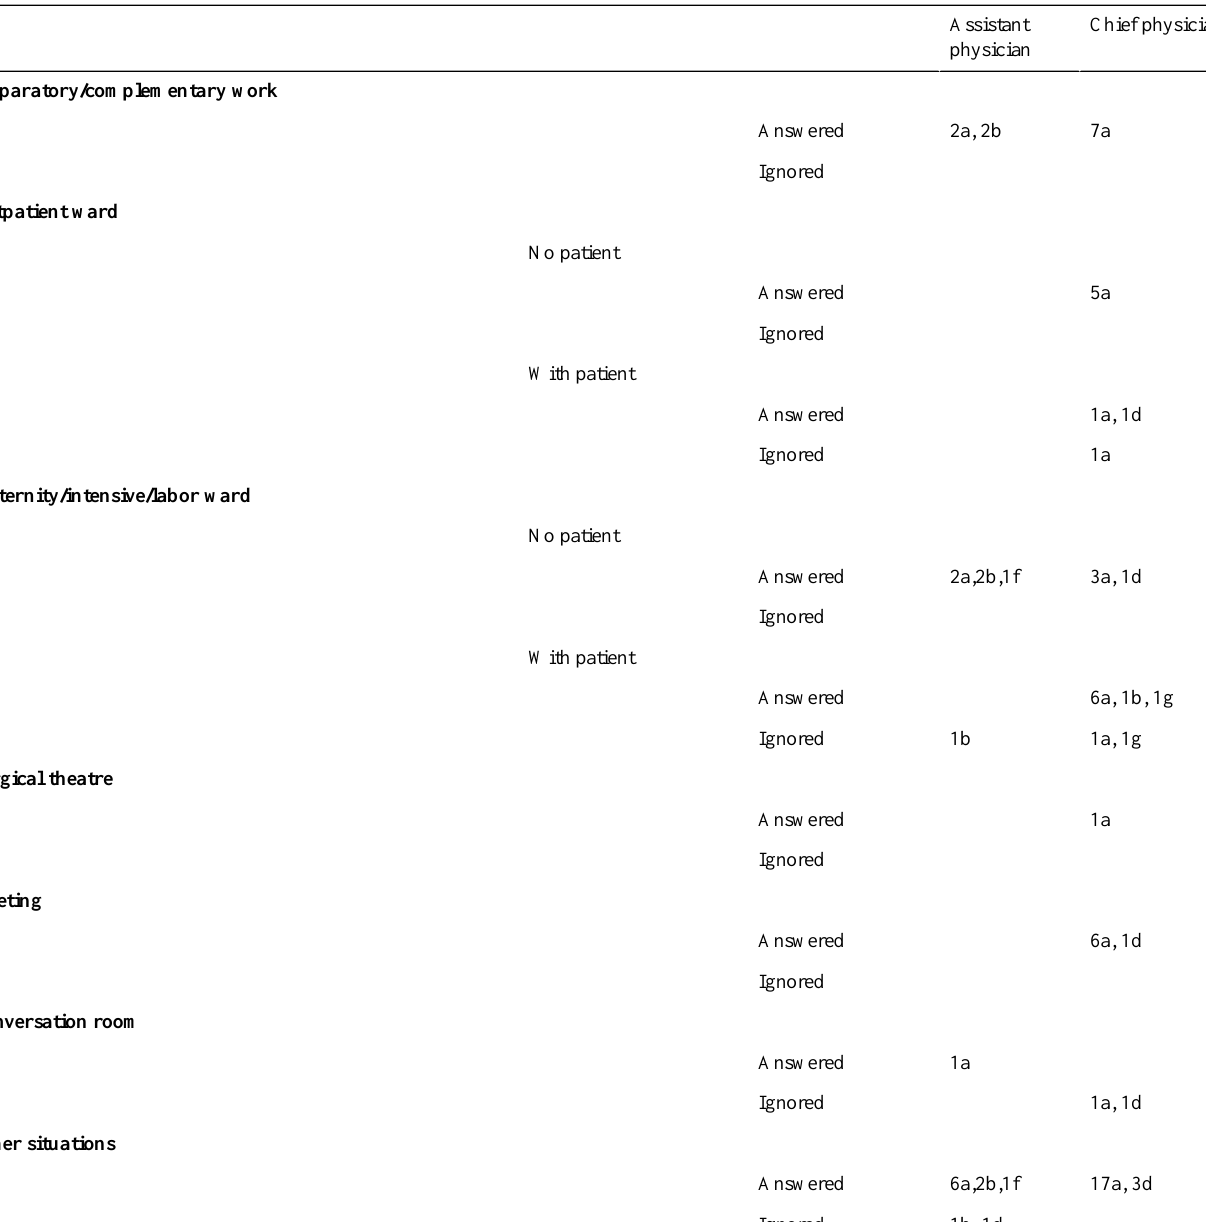
Table 2. Overview of total amount of interruptions from mobile devices at the ENT clinic during observation time (only interruptions from the followed physicians’devices, except for g , which was a nurse’s phone, brought to the physician).